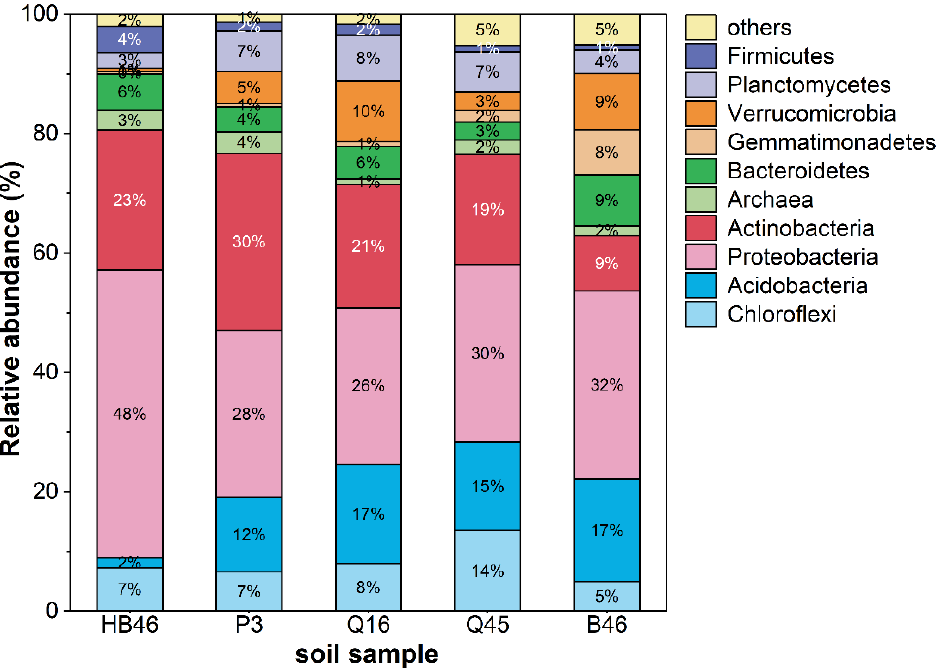
Figure 2. Relative abundance of phyla of soil bacterial community based on the NGS. The classifi- cation with less than 1% abundance is classified as ‘other’. The data points represent the abundance of each phylum relative to all phyla in each soil sample.